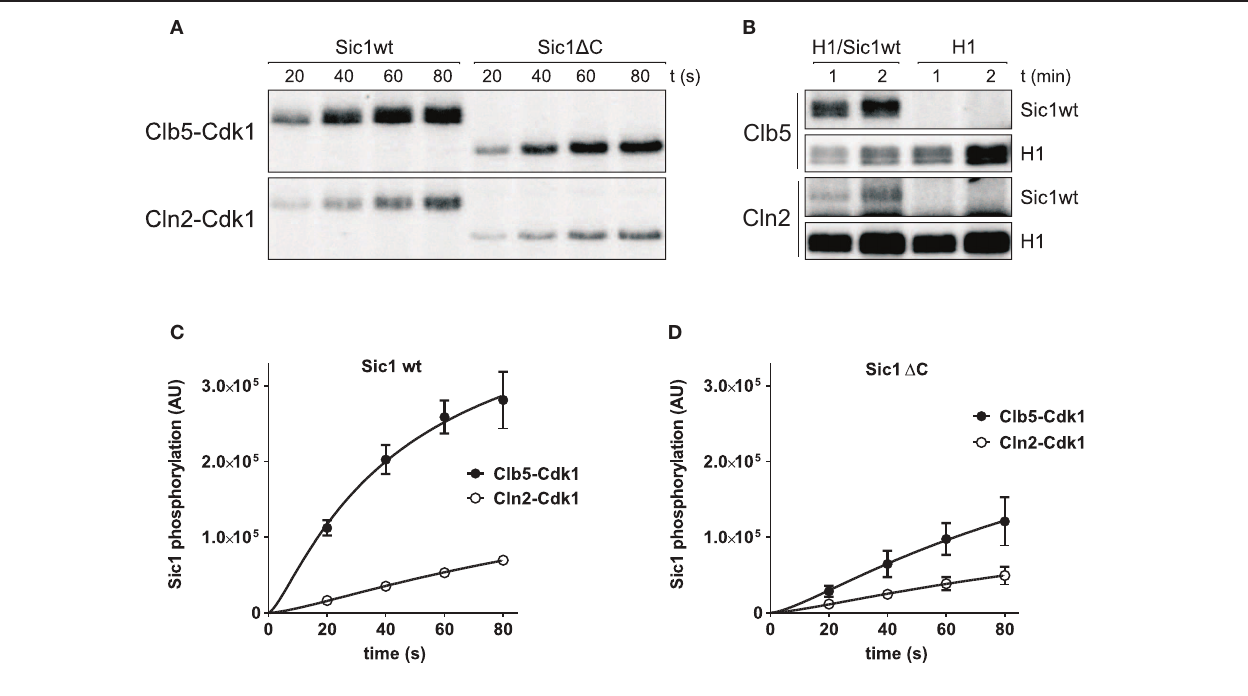
FIGURE 2 | Sic1 is efficiently phosphorylated within the Sic1/Clb5-Cdk1 complex, when an excess of Clb5-Cdk1 is added. Assays with Cln2-Cdk1 complexes are included for comparison. (A) Autoradiography showing the phosphorylation of purified Sic1wt and Sic1 (cid:2) C by Clb5-Cdk1 and Cln2-Cdk1 complexes using 15nM Sic1 and